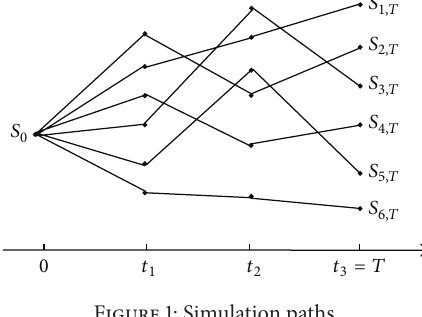
Figure 1: Simulation